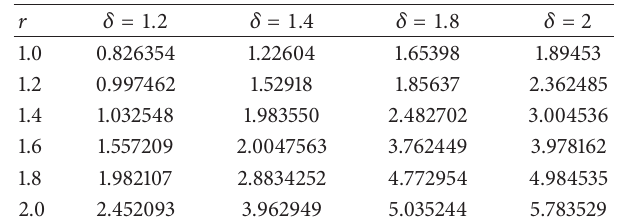
Table 4: Velocity profile for various values of 𝛽 1 , when 𝛽 2 = 0.2 , 𝜆 = = −0.001243429 , 𝐶 = −0.000248121 , 𝐶 0.3 , 𝛿 = 2 , 𝐶 1 2 = 0.000294127 . 0.001032981 , and 𝐶 4